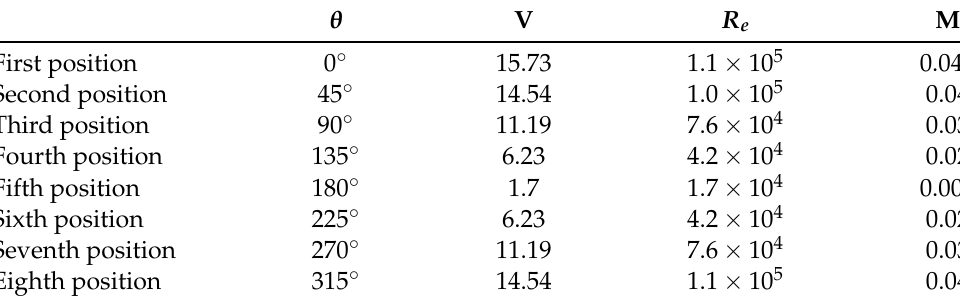
Table 2. Operating conditions at the eight azimuthal positions.